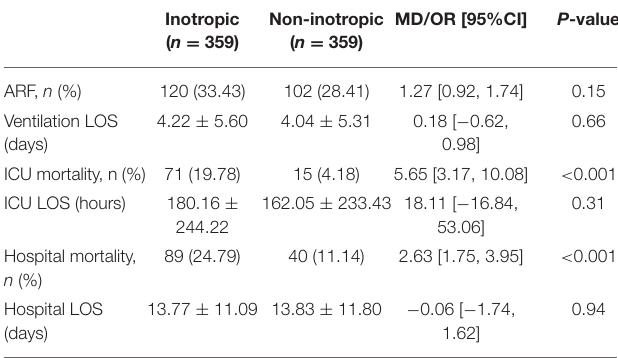
TABLE 4 | Clinical outcomes after propensity score matched by cardiac index between inotrope group and non-inotrope group. Inotropic Non-inotropic ( n = 359) ( n = 359)